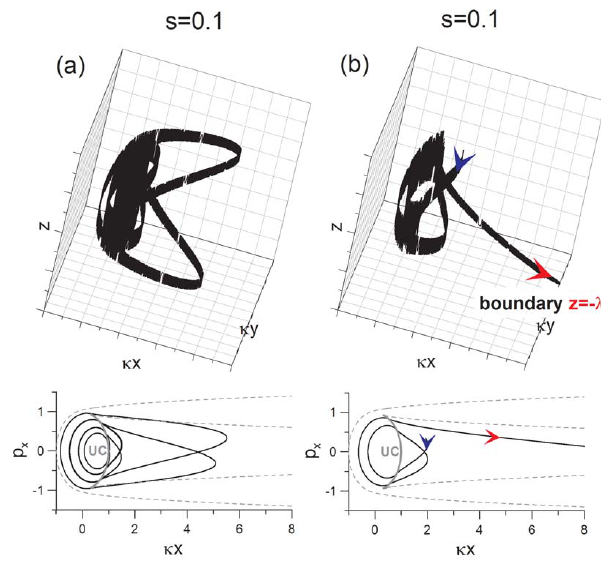
Fig. 7. Particles’ trajectories and corresponding projections onto the (κx,p x ) plane.